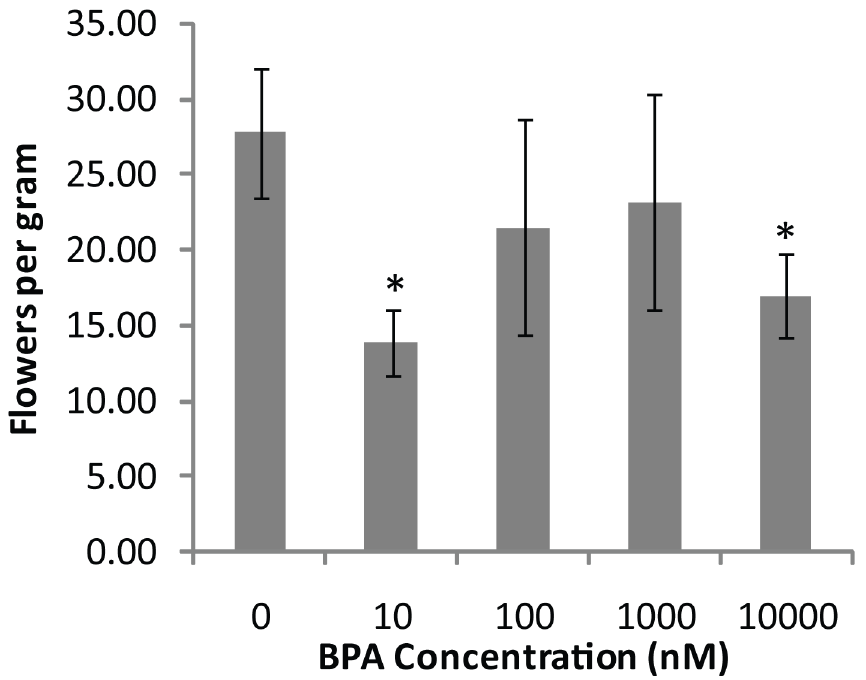
Fig 4. The effect of BPA on plant flowering. BPA may disrupt flowering in A . thaliana . Bars represent the average of four jars of plants grown on agar containing BPA at each concentration. Error bars represent standard error. * indicates p-value < 0.05 when compared to 0nM BPA